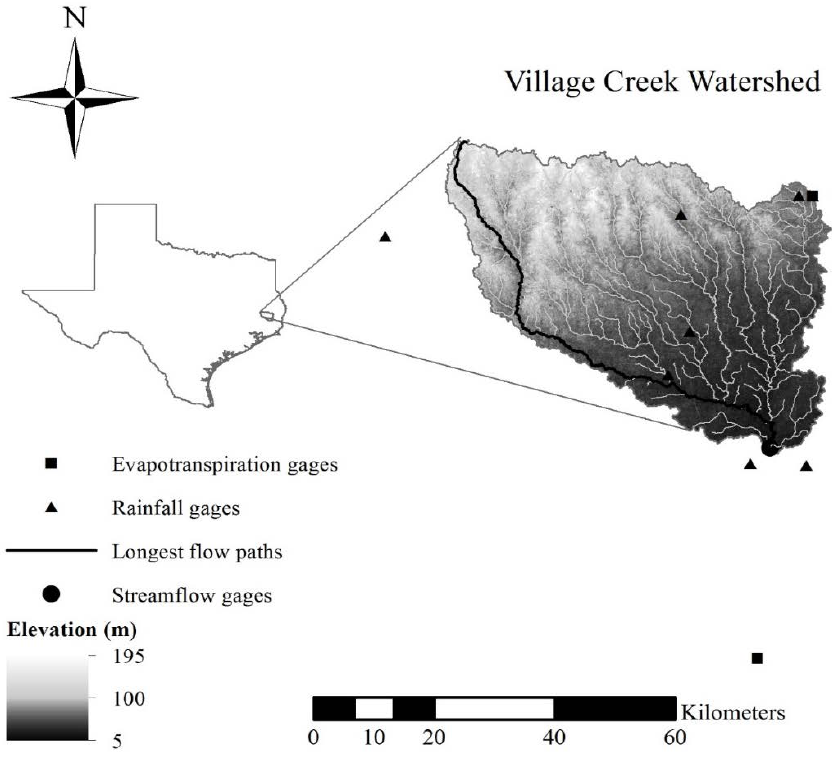
Figure 1. The Village Creek watershed in Texas.